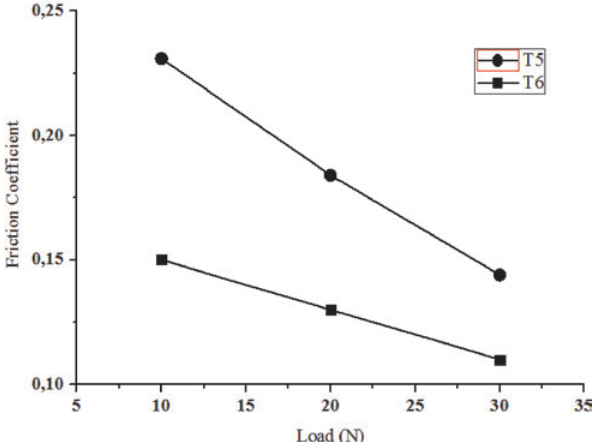
Fig. 4: Friction coefficient graphic based on the applied